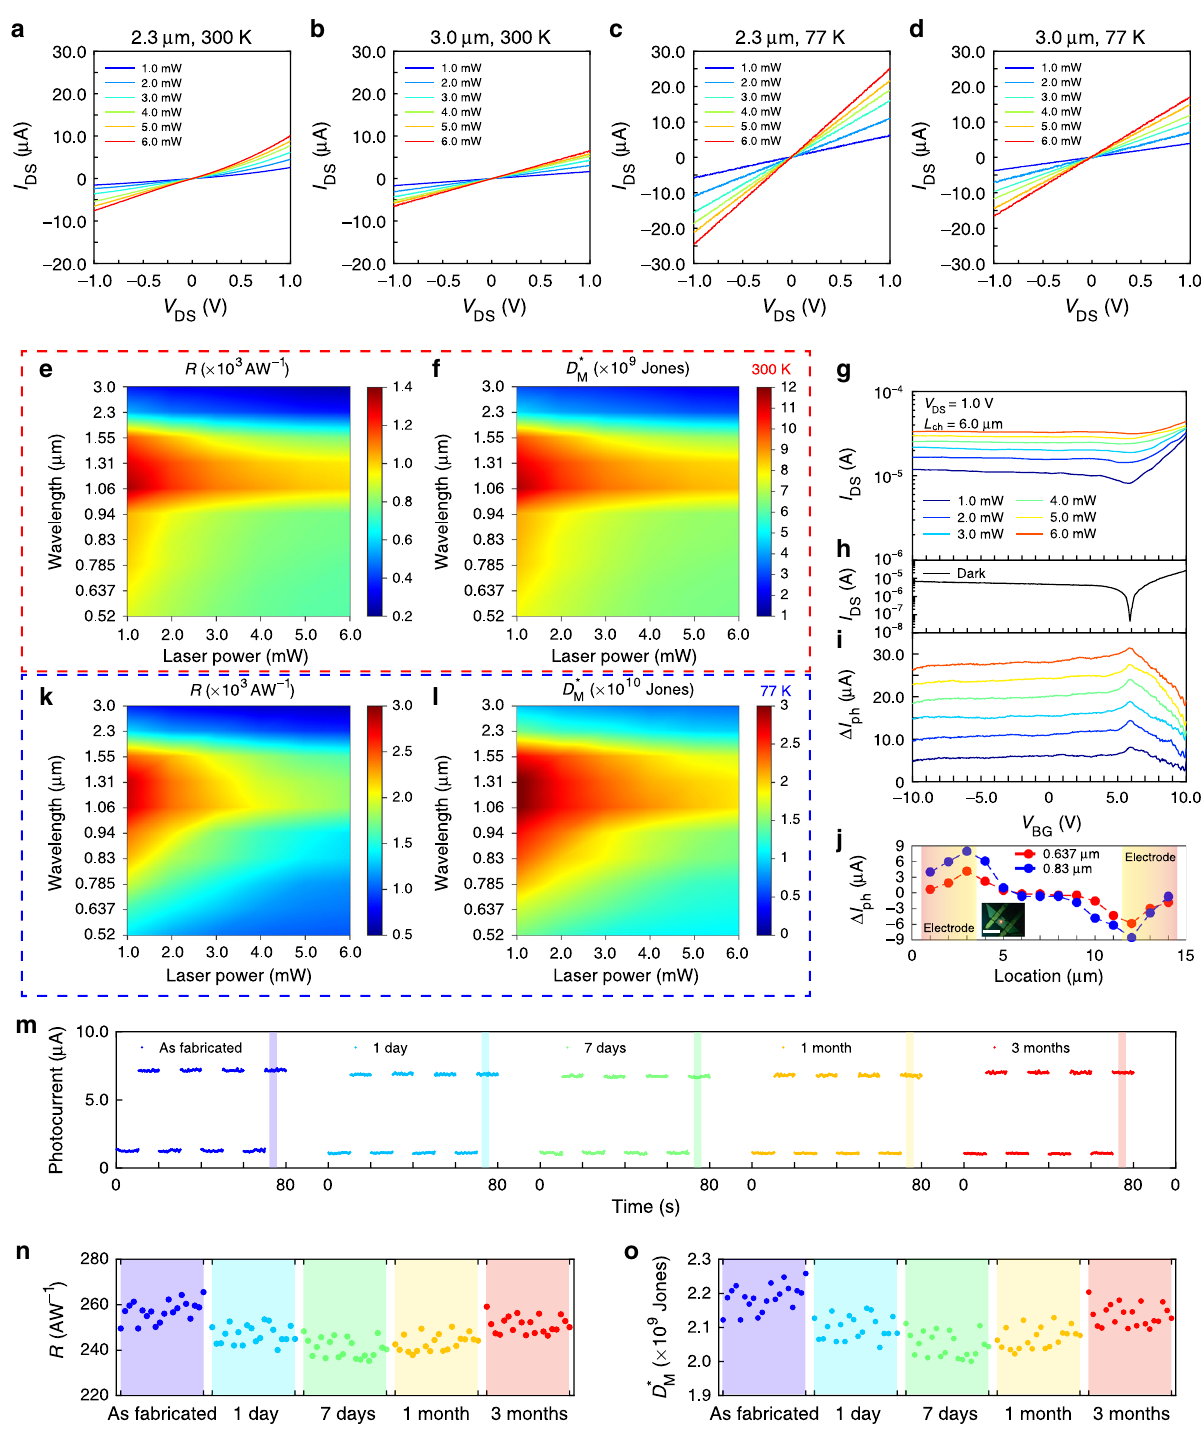
clearly observed to demonstrate that the Te photodetector can identify the slight differences between different polarized illuminations. The photocurrents under 1.0 V drain bias for different incident polarization angles are shown in Fig. 3d – f, corresponding to the incident wavelengths of 0.52, 1.55, and 2.3 μ m, respectively. Even at 0° and 180° polarization direction where the absorption is relatively weaker, obvious photoresponse is still observed, which also ensures the high performances of the device for polarization applications. The visual polarized photo- responsivities are presented in polar diagrams, as shown in